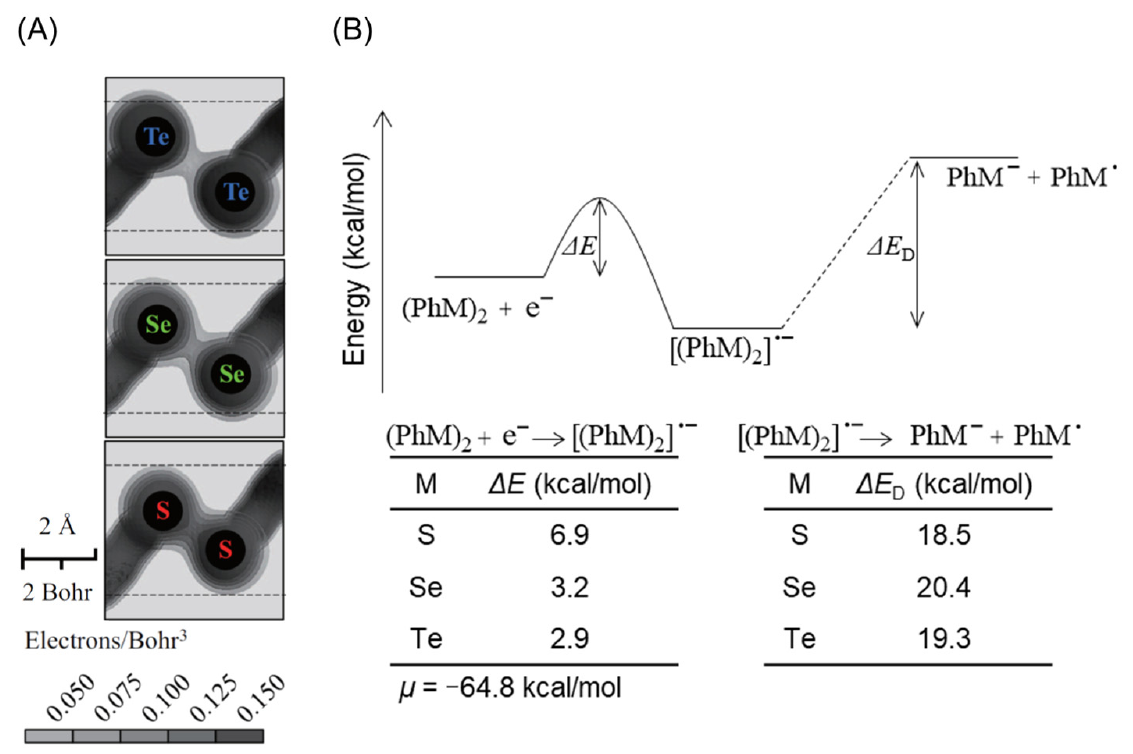
Figure 2. Estimated cleavage process of DPDTe, DPDSe, and DPDS. ( A ) Electron density of DPDTe, DPDSe, and DPDS determined by ab initio quantum chemical calculations. The darker the black, the higher the electron density. ( B ) Energy diagram of DPDTe, DPDSe, and DPDS in heterolytic cleavage